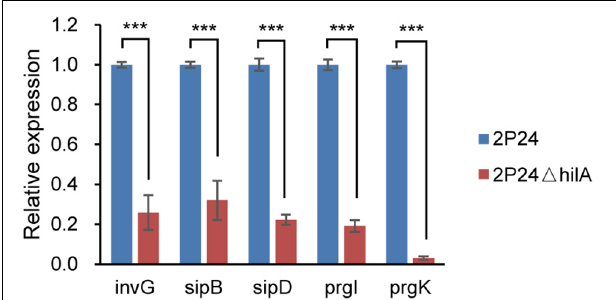
FIGURE 3 | Expression profiles of invG , sipB , sipD , prgI , and prgK in strains 2P24 and 2P24 (cid:49) hilA by quantitative reverse transcriptase-polymerase chain reaction (qRT-PCR). Graph shows gene expression levels in strains 2P24 or 2P24 (cid:49) hilA at 12 h after being incubated in MG medium, as quantified by qRT-PCR. Gene expression was normalized to the expression level of reference gene recA using the 2 − (cid:49)(cid:49) Ct method. Data are means of three replicates. Error bars represent SD. *** represents P <